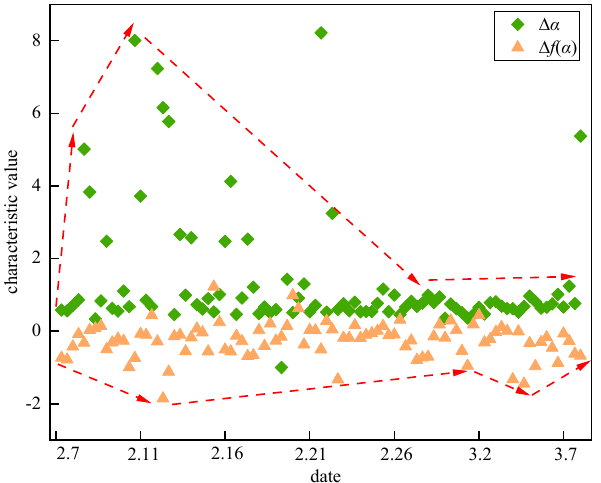
Figure 14. Multifractal development and variation law of rock mass in goaf.